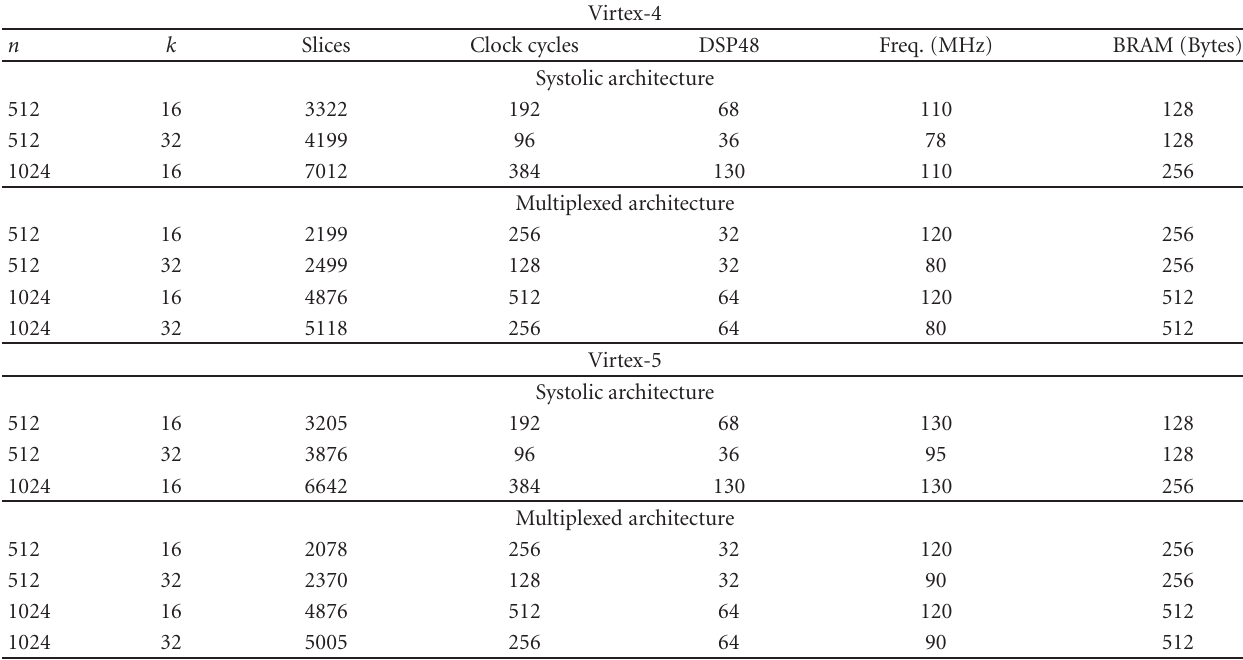
Table 1: Proposed architectures synthesis.